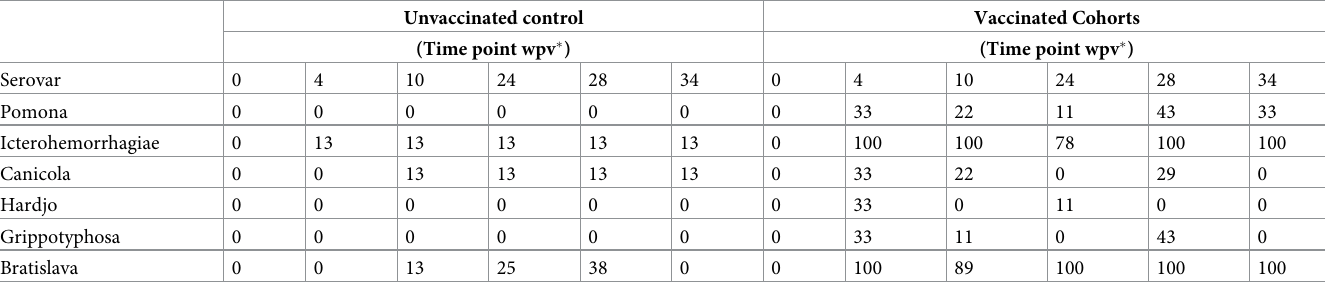
Table 1. Percentage of pigs with a reciprocal MAT titer > 100 for each serovar.